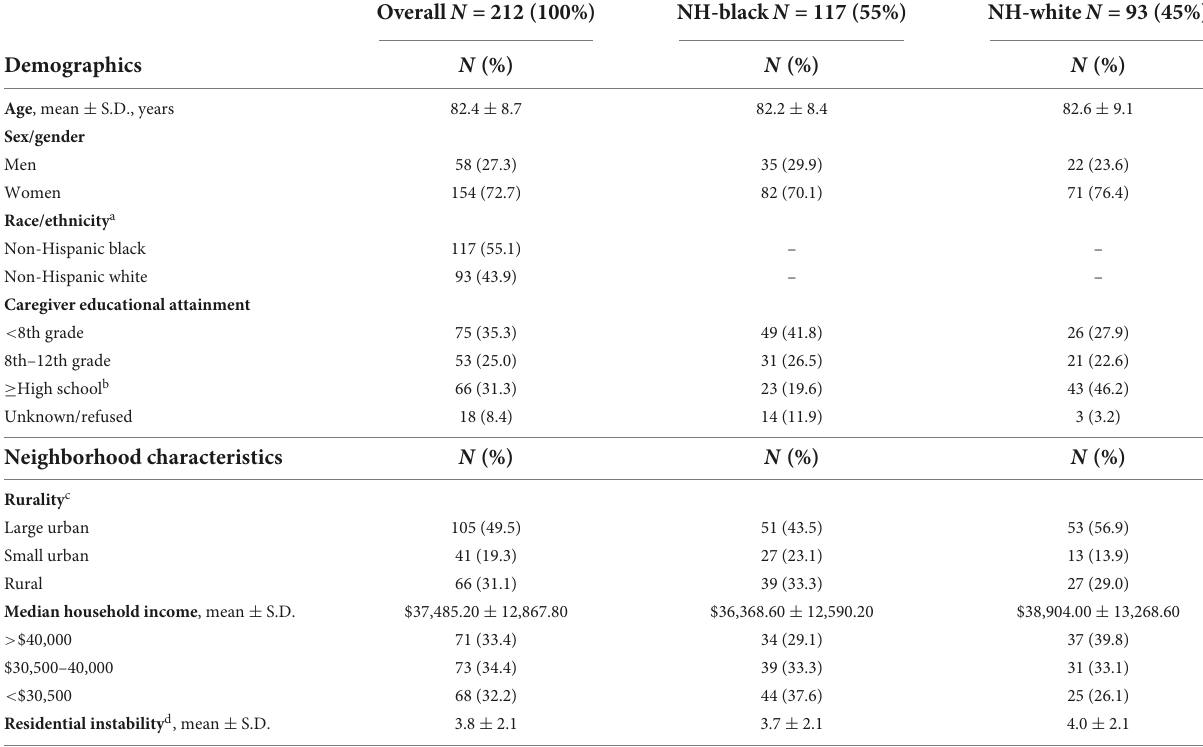
TABLE 1 Demographics and neighborhood characteristics of community-dwelling older adults with Alzheimer’s disease living with a caregiver and stratified by race/ethnicity, 2010 ( n = 212). Overall N = 212 (100%)